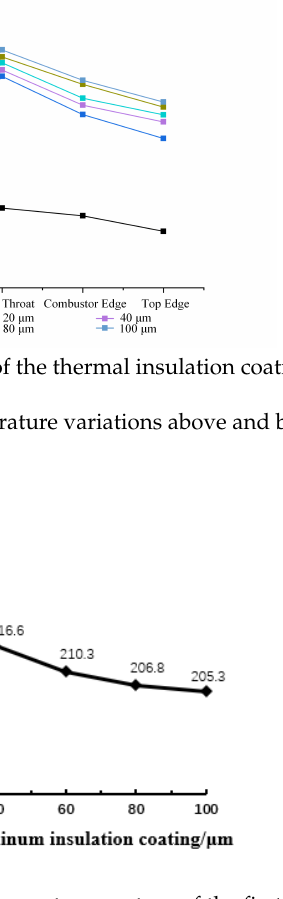
perature distribution of the uncoated piston and the basal body of the coated piston is basically the same, and the top surface temperature of the uncoated piston is lower than all the coated pistons. The numerical calculation is consistent with experimental result [24]. This phenomenon is due to a high thermal conductivity difference between the piston material and the thermal barrier coating. More heat can flow down into the skirt of the uncoated piston achieving better heat dissipation effect, while the heat is blocked by the insulation coating and is concentrated on the top surface of the